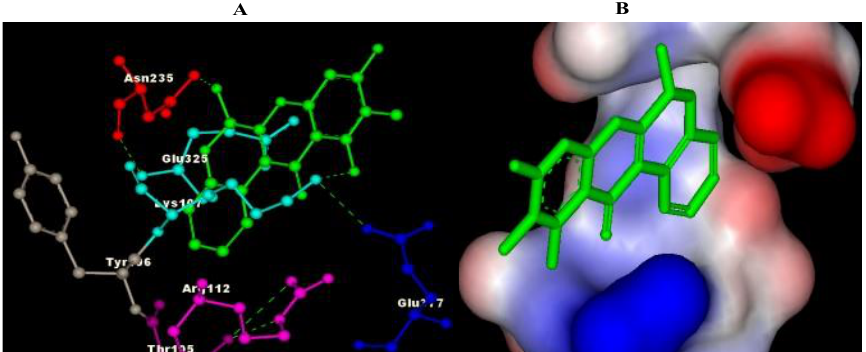
Figure 4. Pictorial representation of molecular docking analysis. (A) Binding orientation in the docked complex of CR with BB. (B) Surface representation of the CR binding pocket with the BB. The compound BB is represented in green. Images were generated using Discovery Studio visualizer.